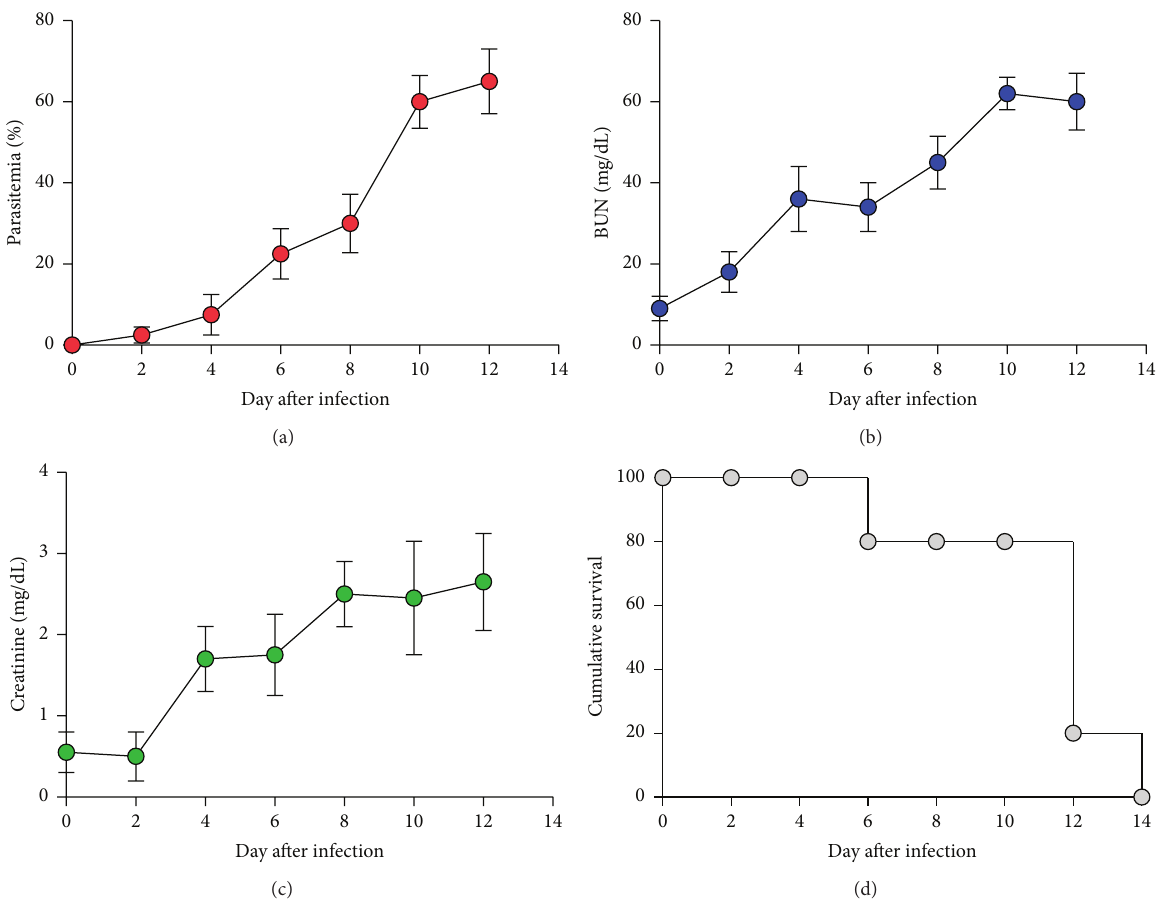
Figure1:Malaria-associatedrenalinjuryinducedby Plasmodiumberghei infectioninmice.GroupsofICRmice(5miceofeach)wereinfected with 1 × 10 7 parasitized erythrocytes of PbANKA by IP injection. (a) Parasitemia, (b) BUN, and (c) creatinine levels were daily measured. (d) Cumulative survival of infected mice was also observed. Results were expressed as mean ±